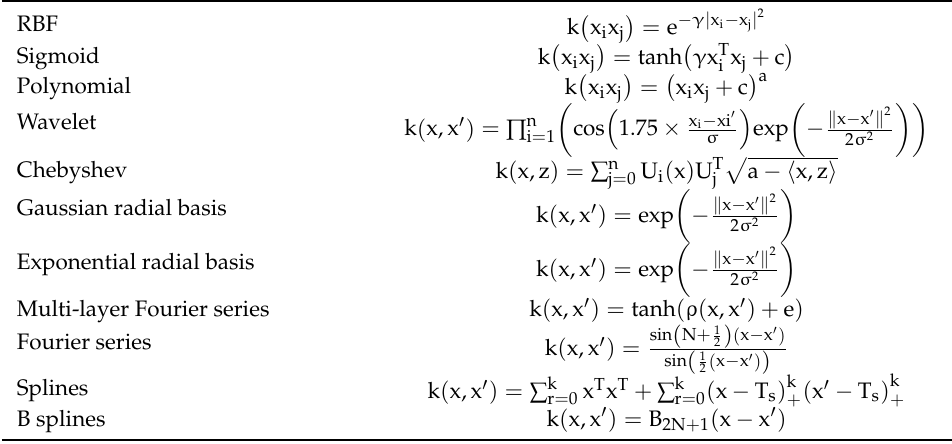
Table 2. Different types of kernel